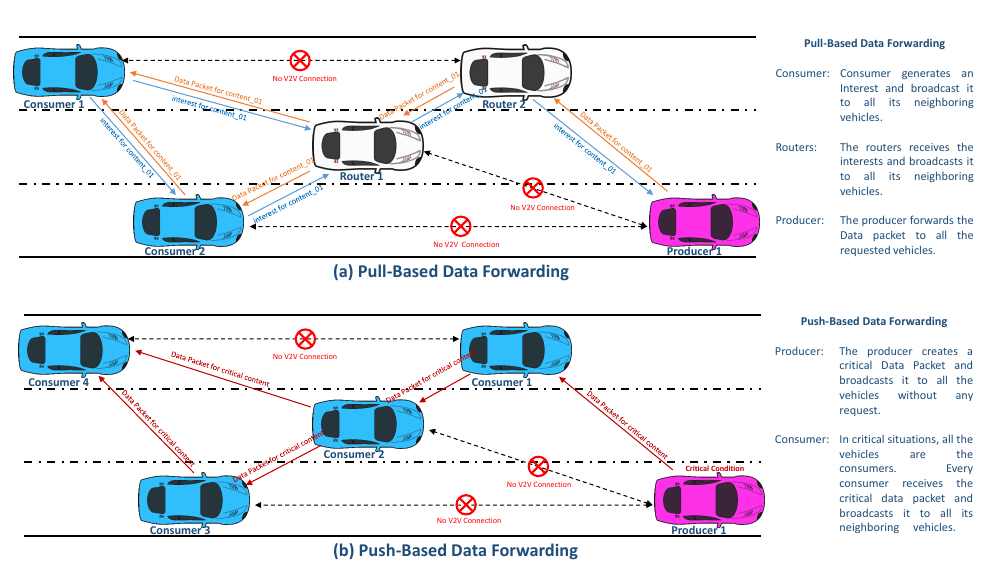
Figure 2. Comparison of pull-based and push-based data forwarding in